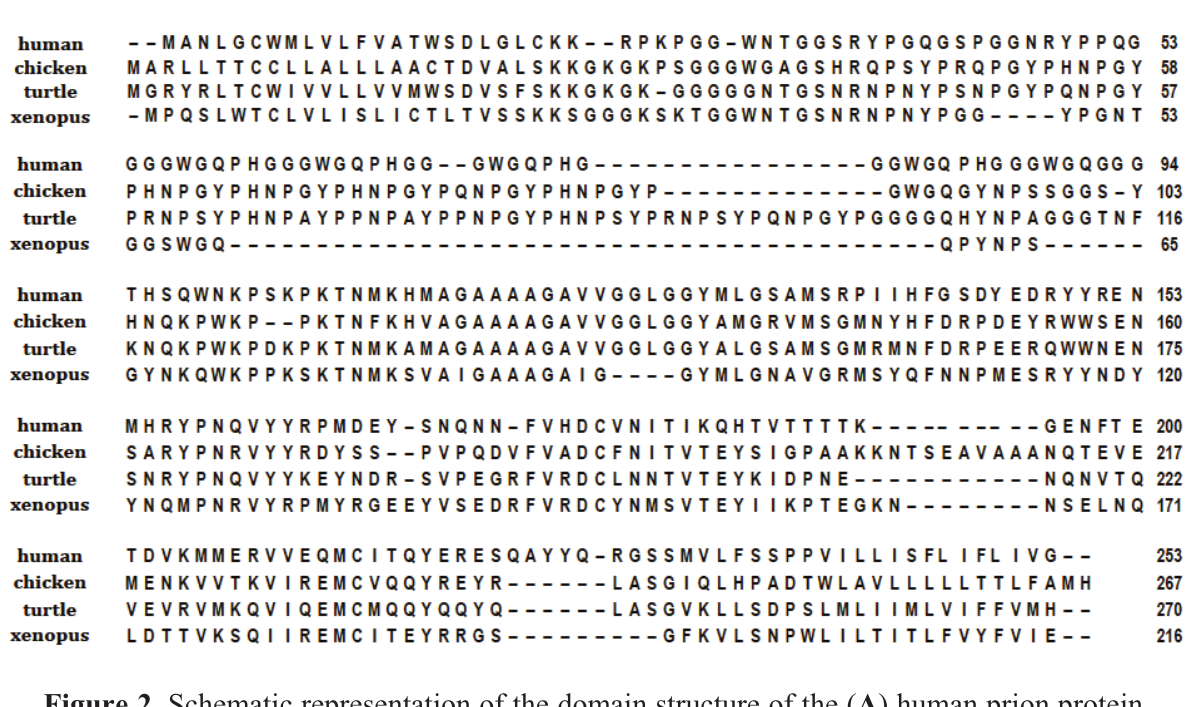
Figure 2. Schematic representation of the domain structure of the ( A ) human prion protein and ( B ) chicken prion